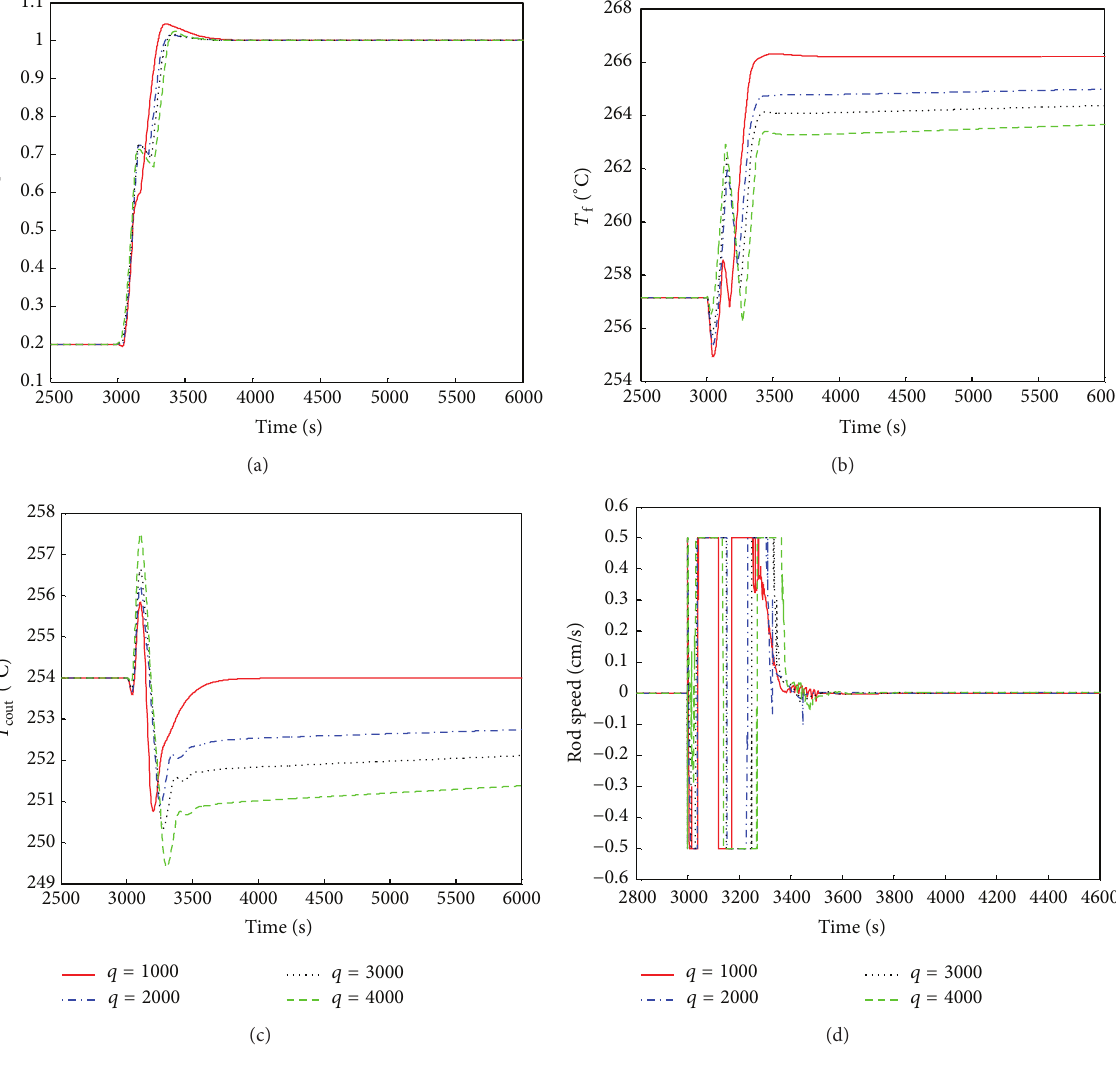
Figure 4: Simulation results in Case